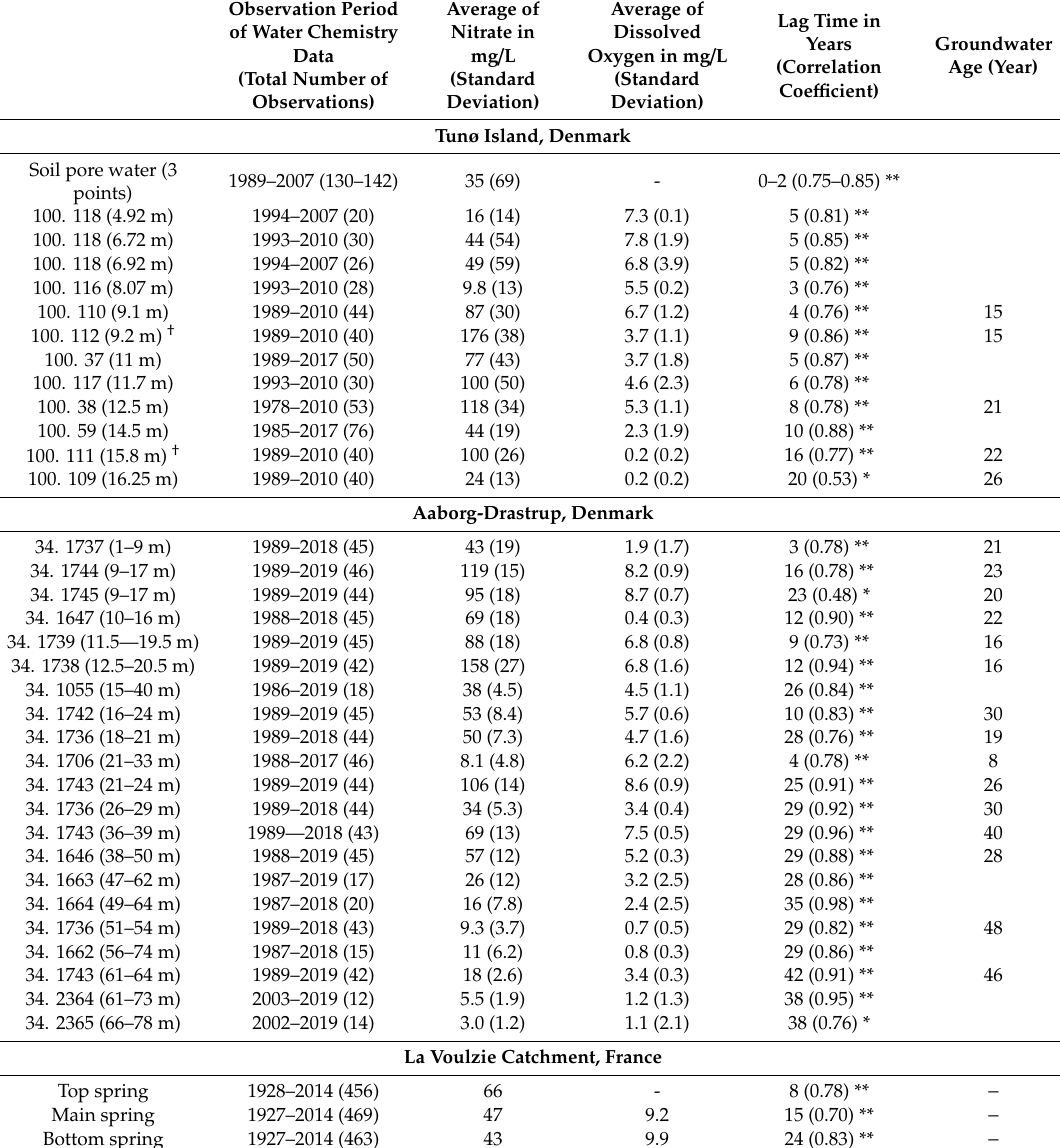
Table 2. Summary of water chemistry and the lag time